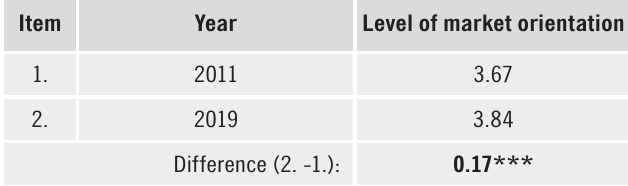
Table 7. The average level of market orientation in high-tech manufacturing companies sampled in 2011 and 2019 Item Year Level of market orientation 1. 2011 3.67 2. 2019 3.84 Difference (2. -1.):